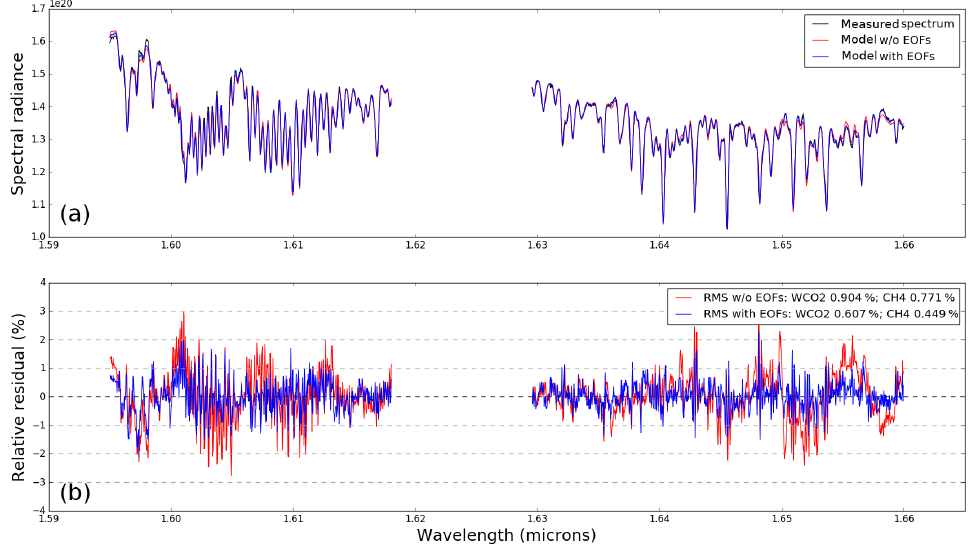
Figure 20. Example spectral fit residuals for the Band 2A CO 2 (left) and CH 4 (right) fit windows, using a sun-glint spectrum measured during the 10 March 2015 Global Hawk flight. The measured and optimized forward modelled spectra (both with and without EOFs included in the retrieval algorithm) are plotted in (a) , whilst (b) shows the spectral fit residuals in each case (modelled – measured) as a percentage of the measured spectrum.